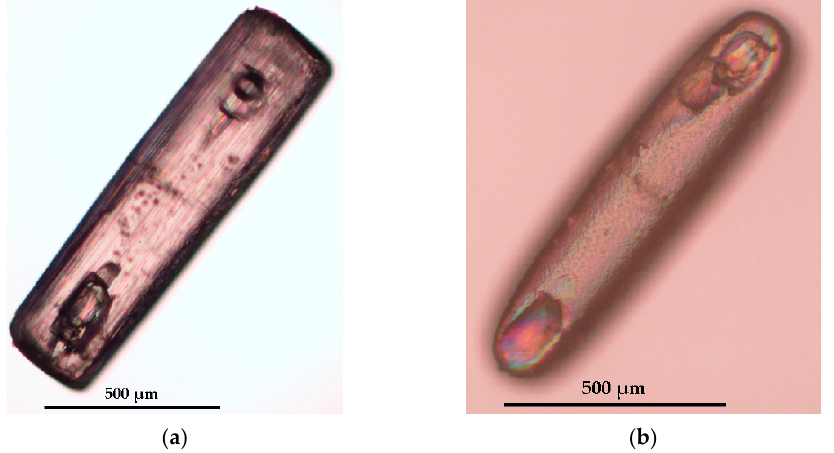
Figure 12. Fibrous crystal under heating (from 20 °C to 120 °C at 1 K/min) at two different stages: ( a ) at T = 20 °C; ( b ) at T